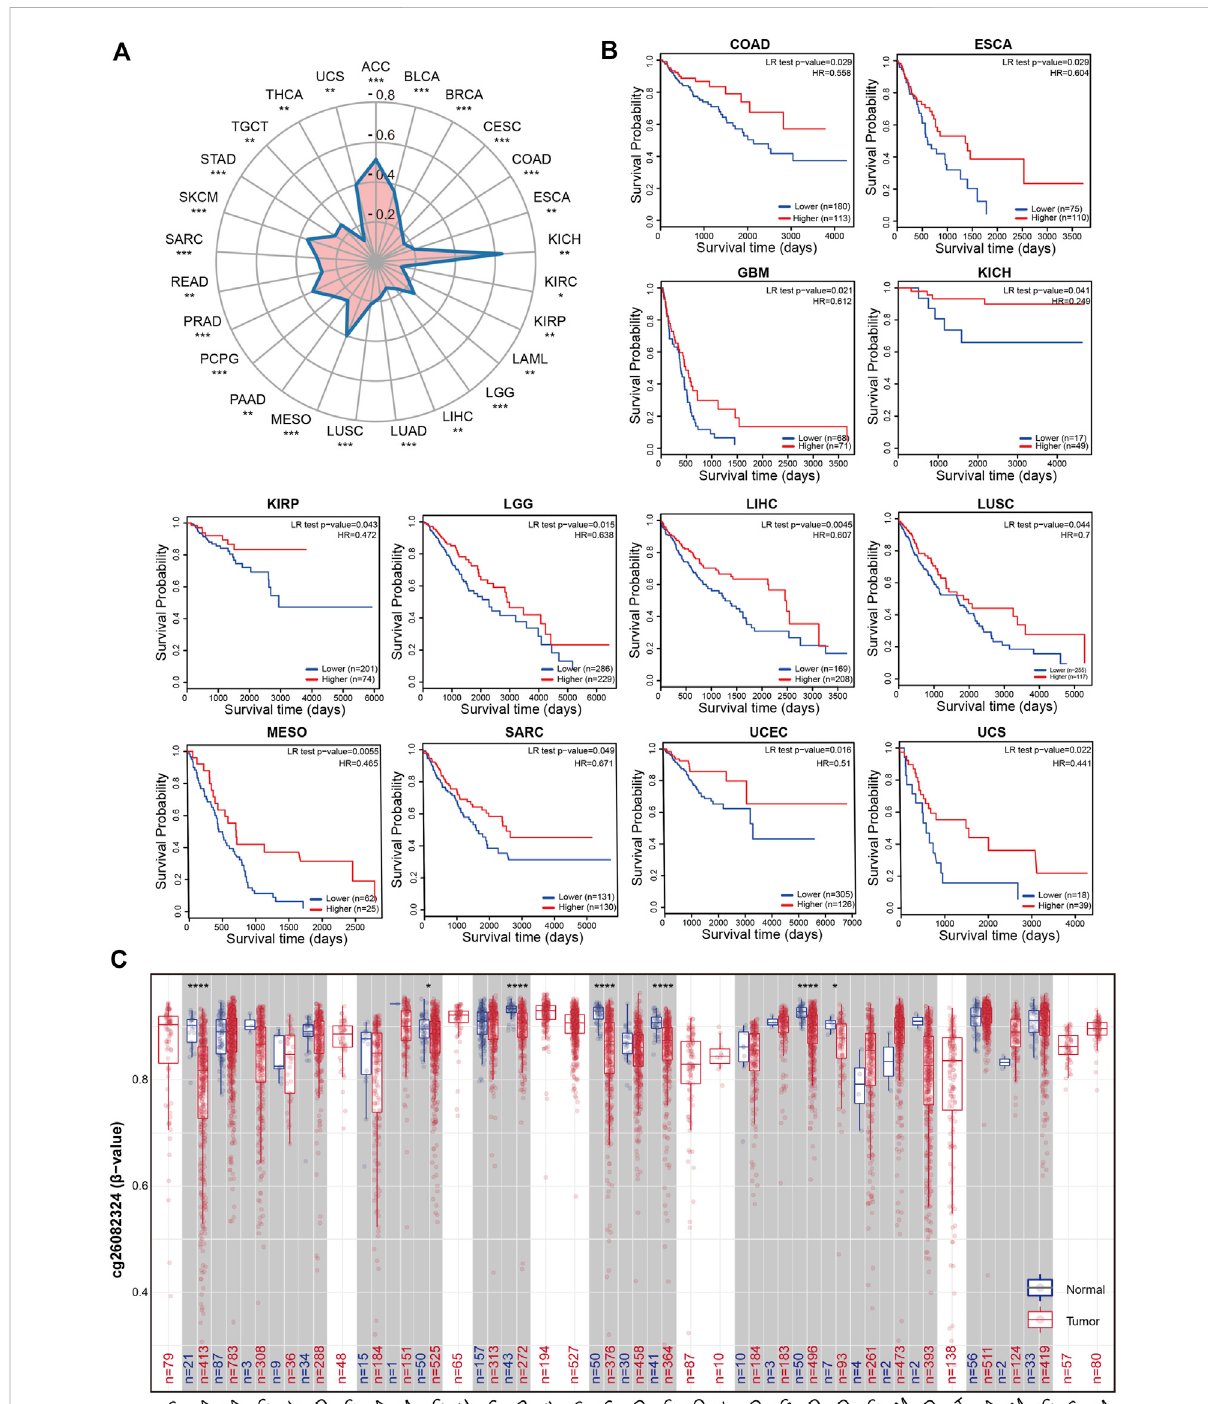
Methylation feature of RIOK2 in different tumors of TCGA. (A) Correlation between the RIOK2 methylation levels and expression is displayed using a radar chart across the various cancer types. The pattern is observed with the CpG island probe cg06664872. The statistical signi fi cance computedbytheSpearmantestisannotatedbythenumberofstars(* p < 0.05,** p < 0.01,*** p < 0.001,**** p < 0.0001). (B) Correlationbetweenthe RIOK2 methylation levels and overall survival is shown by the Kaplan-Meier curves across the various cancer types which have signi fi cant survival risk ( p < 0.05). (C) Differences in RIOK2 methylation levels between tumors and healthy groups are displayed using box plots that are upregulated or downregulated in tumors (red) compared to healthy tissues (gray) for each cancer type. The pattern is observed with the